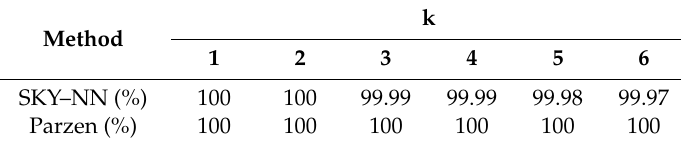
Table 13. Double skyline on the synthetic Dataset II.